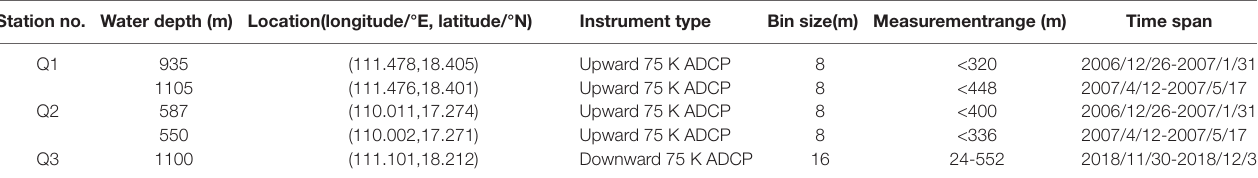
TABLE 1 | Information on the current-observation